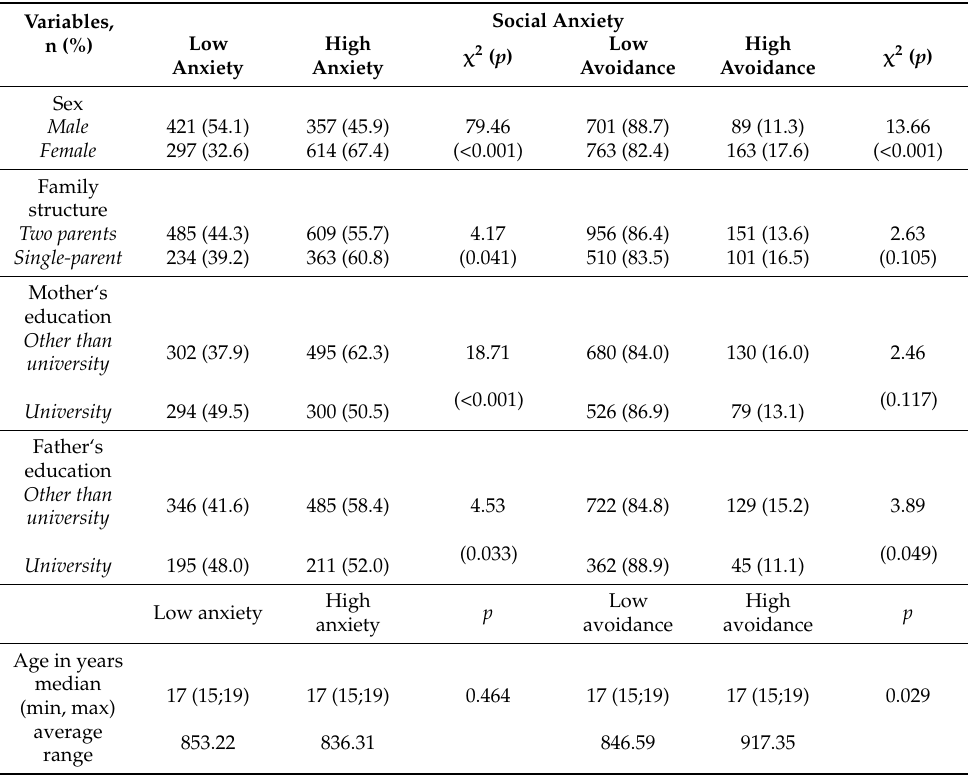
Table 2. SA and sociodemographic factors.